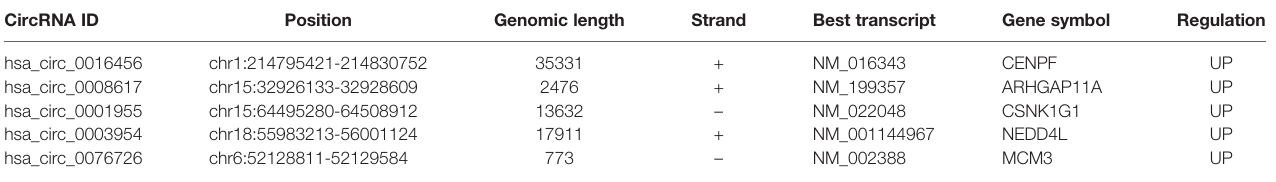
TABLE 1 | Basic characteristics of the top 5 differentially expressed circRNAs in the ceRNA network. CircRNA ID